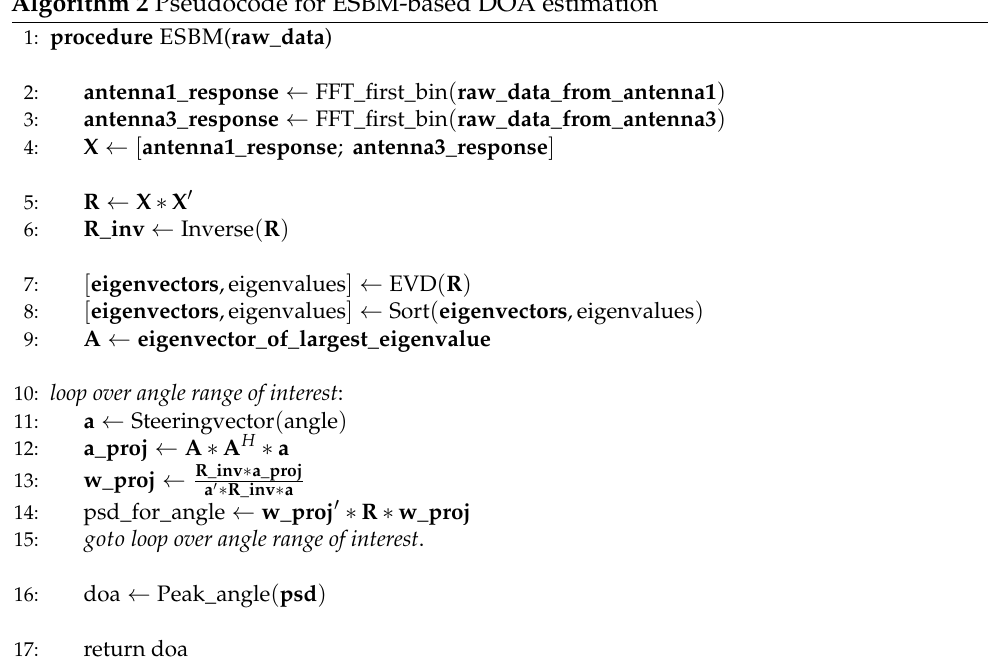
Algorithm 2 Pseudocode for ESBM-based DOA